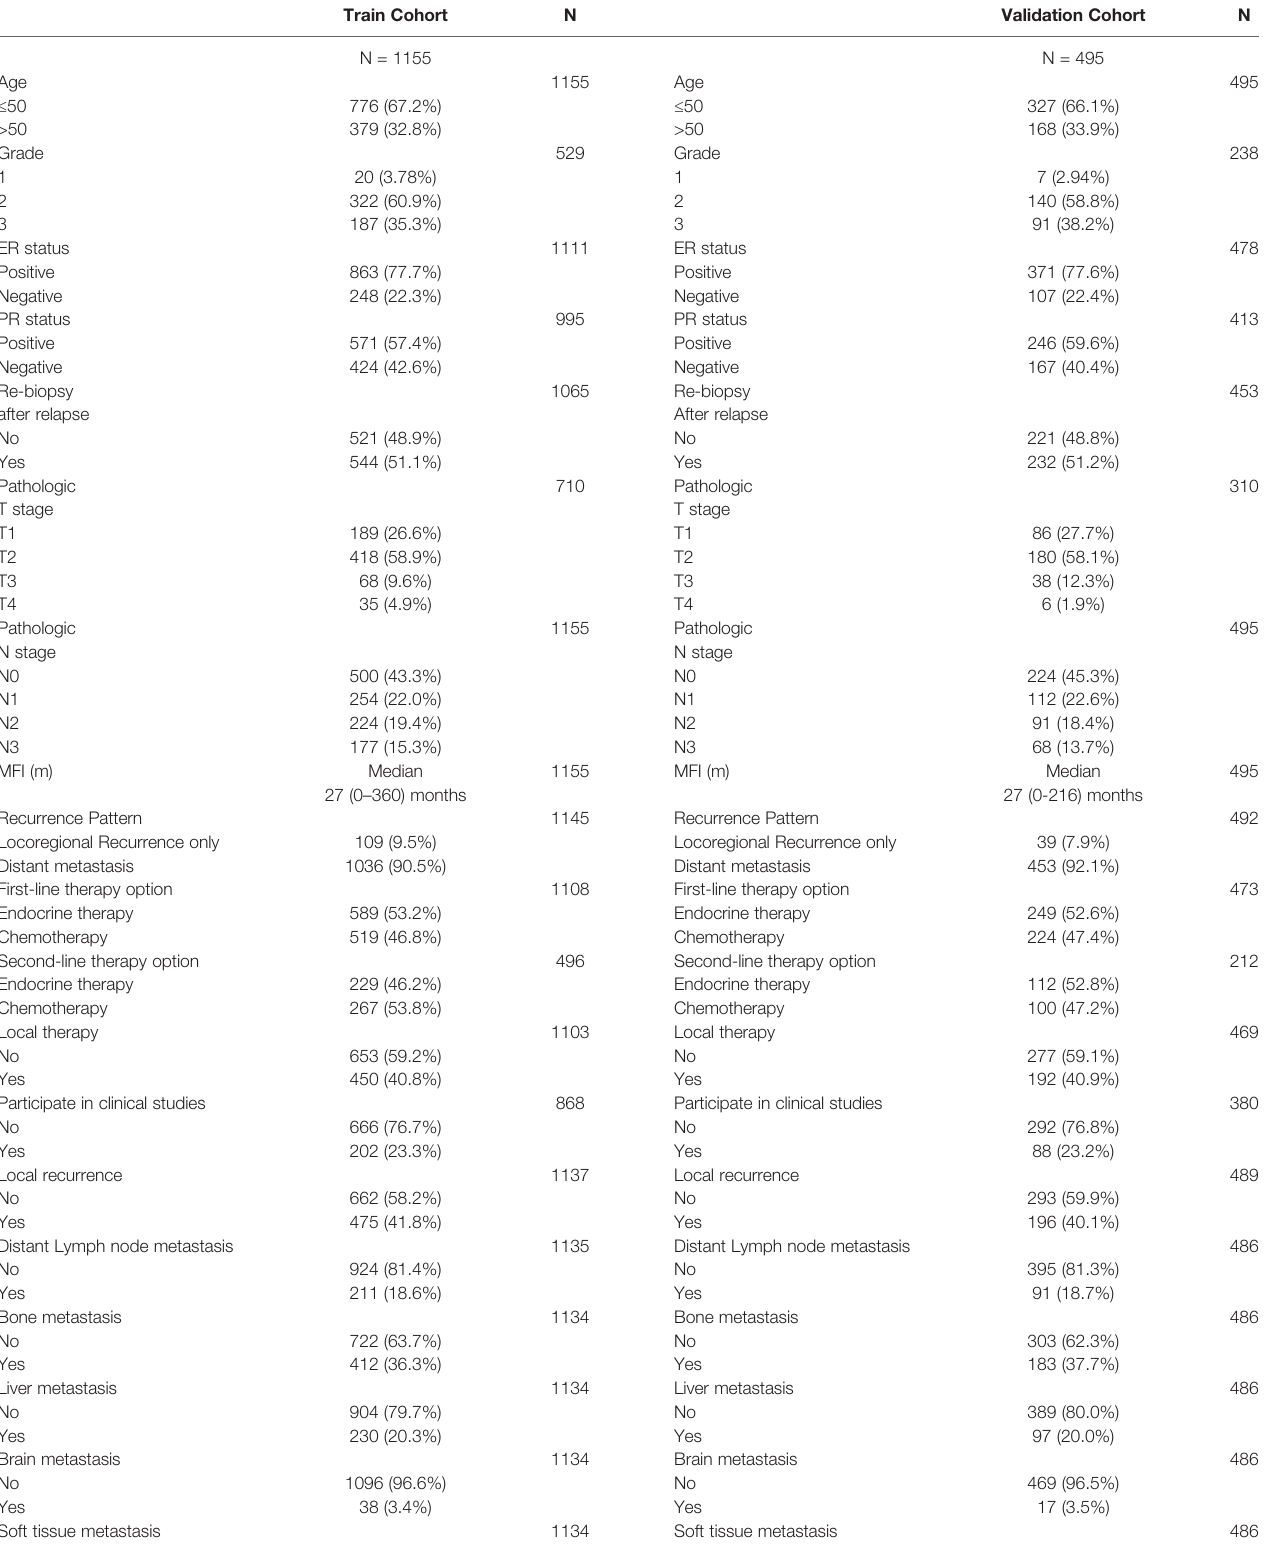
TABLE 1 | Clinicopathological features of patients in the training and validation